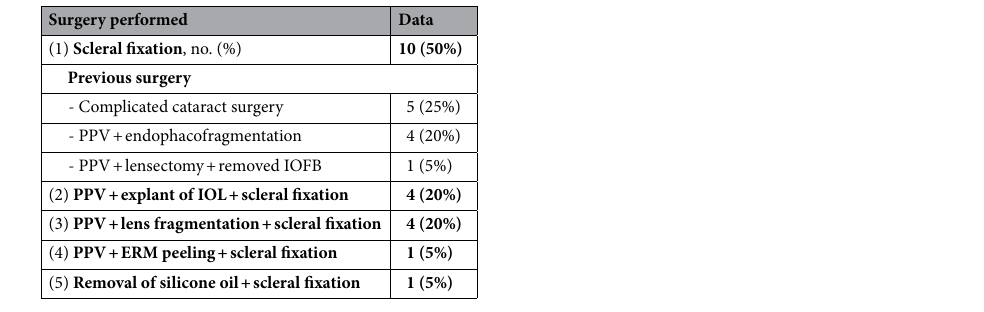
Table 2. Surgical characteristics. ERM - epiretinal membrane, IOFB intraocular foreign